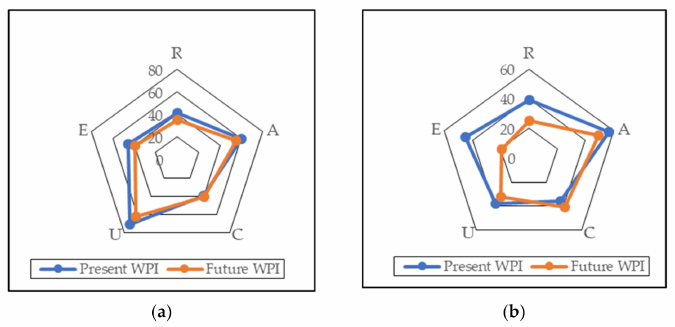
Figure 11. Present and future WPI pentagrams for the economically inactive women group in the ( a ) Dhalla union and ( b ) Saista